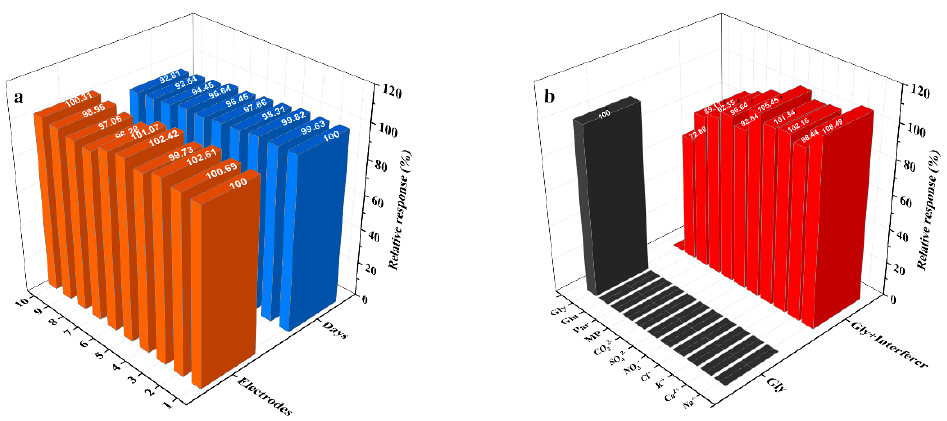
Figure 6. ( a ) Repeatability and stability of CuAl-LDH/Gr/GCE in 0.2 M pH 5.4 ABS solution and ( b ) interference tests of CuAl-LDH/Gr/GCE in 0.2 M pH 5.4 ABS solution with glyphosate and interferers (the concentration of glyphosate was 40 ppb; the other organophosphorus and inorganic ions were separately added to the electrolyte with glyphosate).